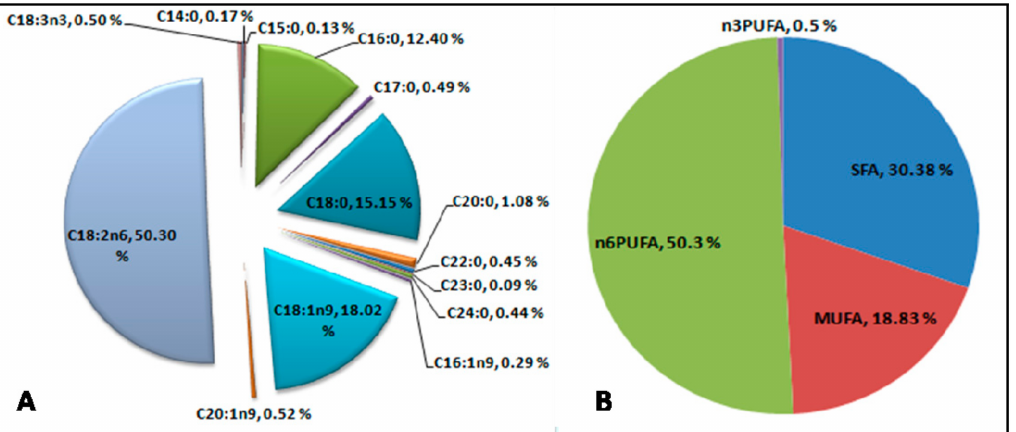
Figure 1. The fatty acid composition of tumba ( C. colocynthis ) seed oil obtained in the present study: ( A ) fatty acid profile and ( B ) fatty acid subclasses distribution in the tumba seed oil (SFA: saturated fatty acids; MUFA: monounsaturated fatty acids; n6-PUFA: omega-6 polyunsaturated fatty acids; n3-PUFA: omega-3 polyunsaturated fatty acids). The values are presented as the weight percentage for individual fatty